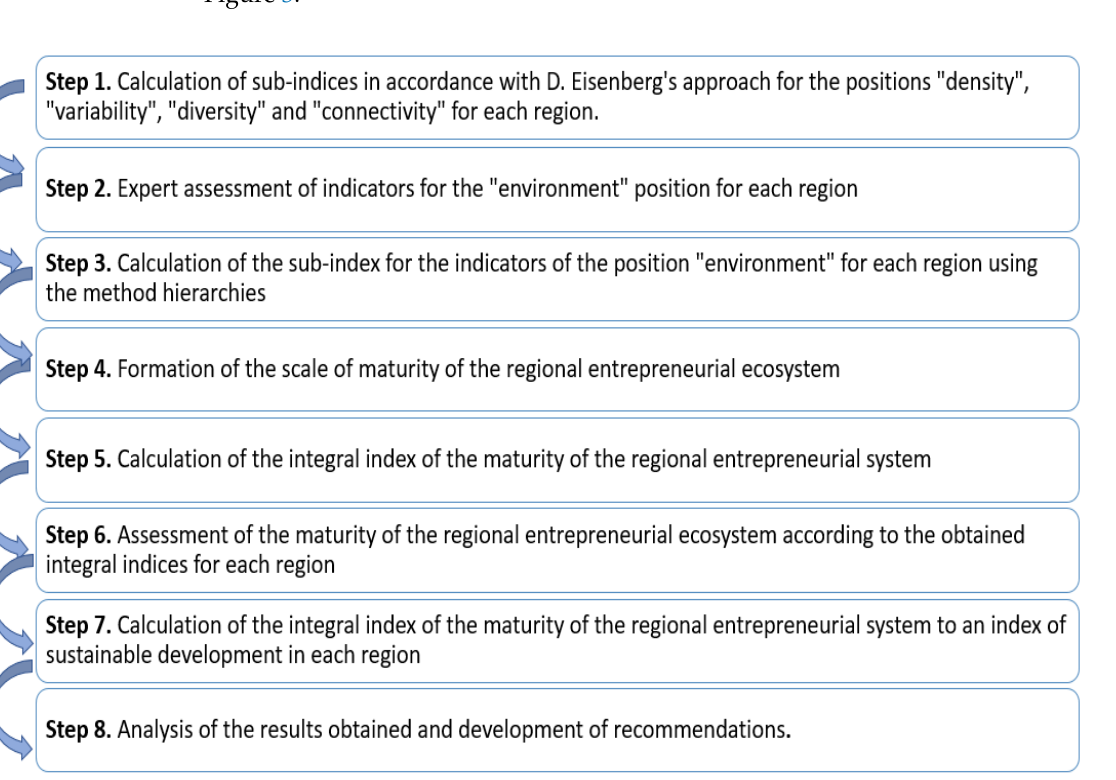
Figure 3. Stages of assessing the maturity of the regional entrepreneurial ecosystem. Source: Own elaboration. The sub-indicators are transformed into an integral indicator for each block by means of standardization, aggregation, and weighting operations. The indicators are obtained as the arithmetic mean of sub-indicators for each of the blocks: where I j is the integral indicator of the j -th block; I i are sub-indicators; k is the number of sub-indicators in each block, k = 1,….., n .